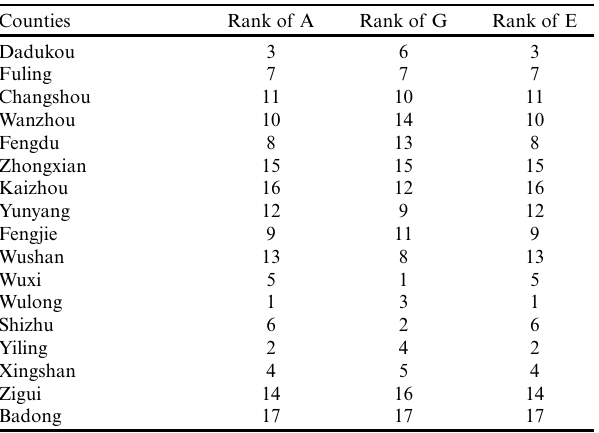
Table 7 . Results from the first centralized sorting.